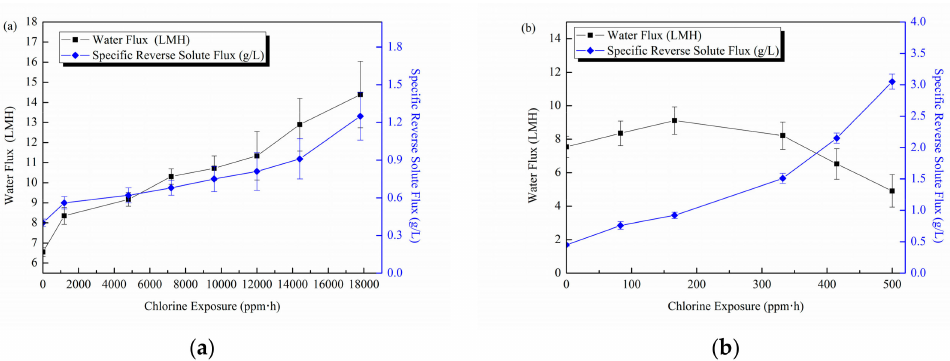
Figure 6. ( a ) The influence of chlorine immersion on the FO performance of M-2 membrane; ( b ) The influence of chlorine immersion on the FO performance of PIP/TMC conventional membrane. The FO performance was tested in active layer-feed solution (AL-FS) mode with 1 M MgCl 2 as draw solution and DI water as the feed